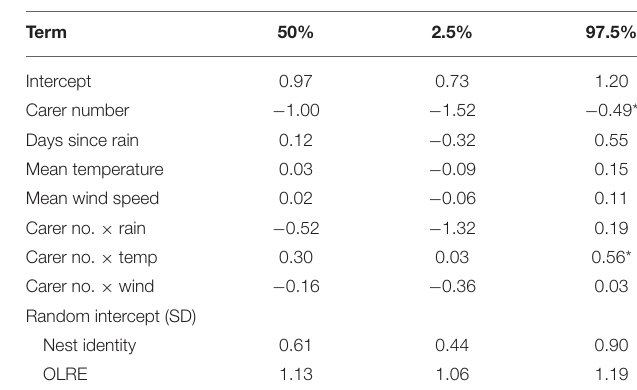
TABLE 4 | Phenological, meteorological, and social effects on group-level synchronization of nest visits.